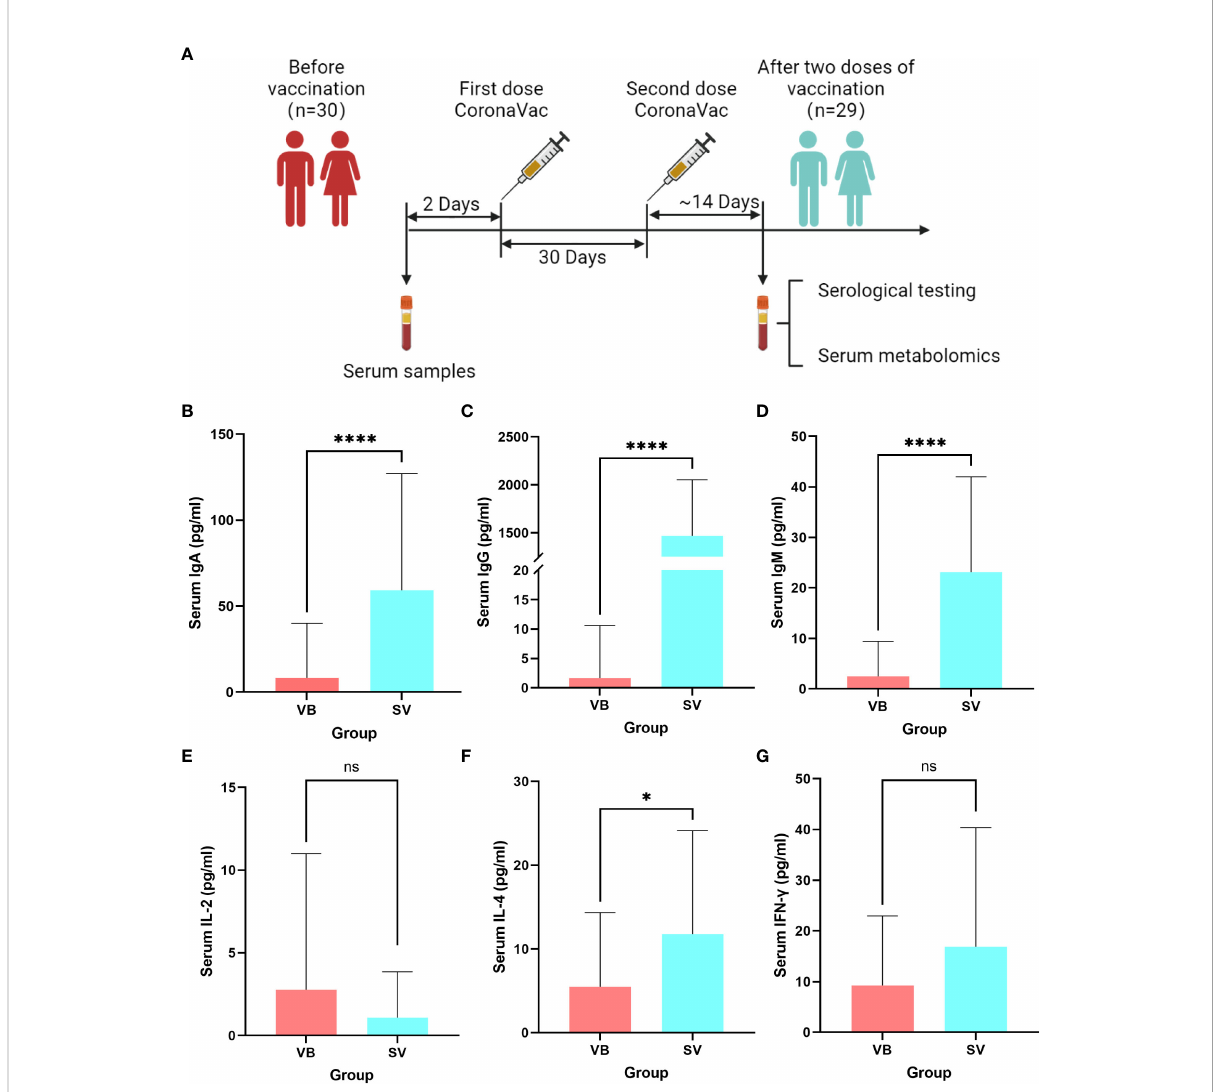
FIGURE 1 Untargeted metabolomic pro fi ling of sera samples collected from volunteers before SARS-CoV-2 vaccination, and 2 weeks after two-dose vaccination. (A) Schematic diagram of the study design. (B – G) Antibodies and cytokines characterized in serum and compared between the VB and SV groups. ns indicates not signi fi cant, single asterisk indicates p<0.05, double asterisks indicate p<0.01, triple asterisks indicate p<0.001, quadruple asterisks indicate p <